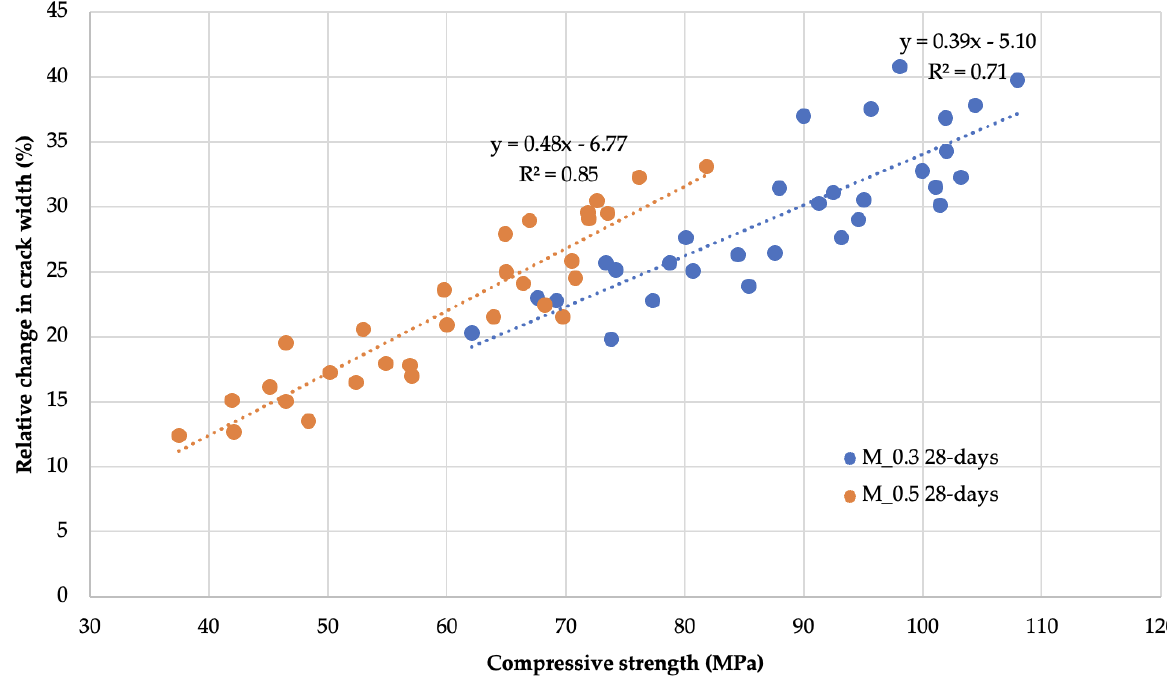
Figure 8. Graph of the dependence of the relative change in crack width after different curing periods on the compressive strength of mortars with cracks induced at day 28 of aging.